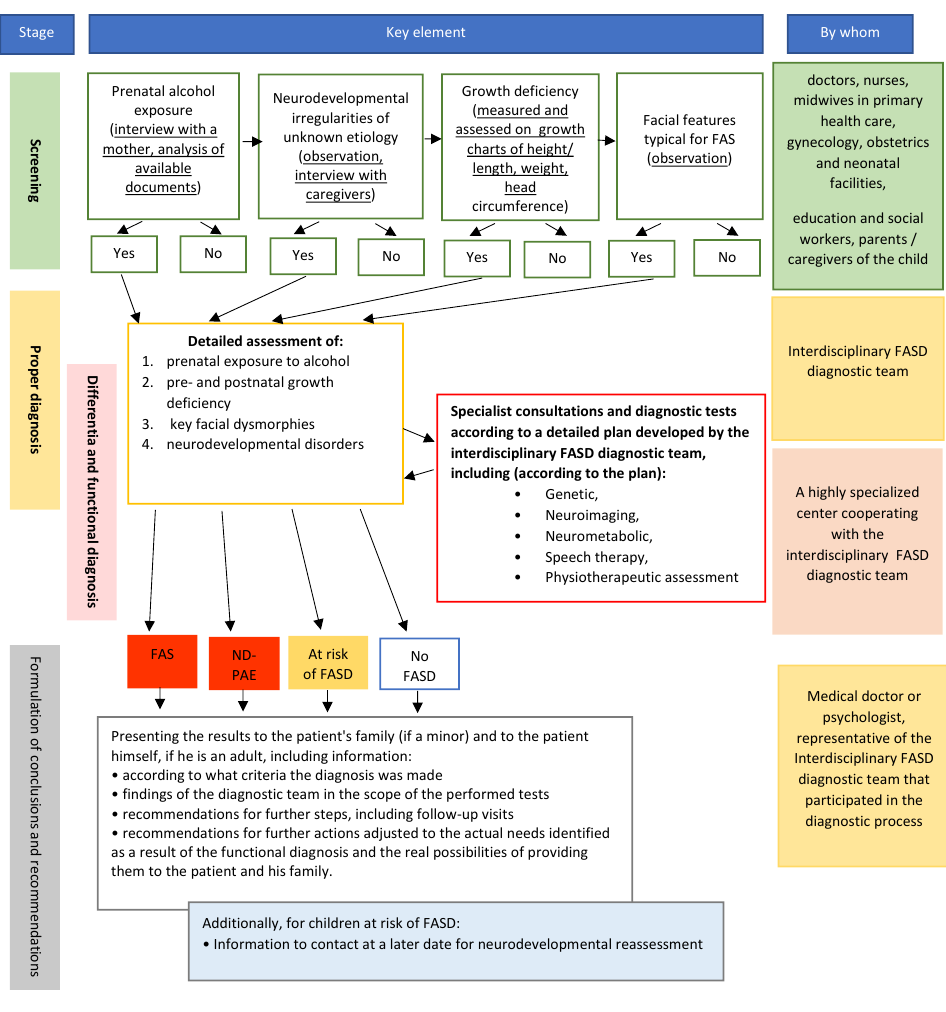
Figure 4. Recommended FASD diagnostic